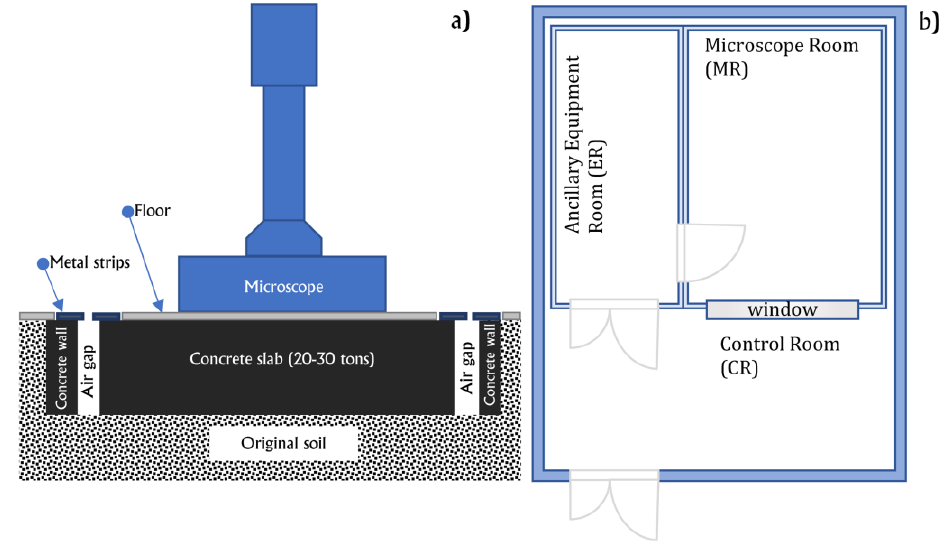
Figure 4. ( a ) Scheme of the anti-vibration block under the microscope in the Instrument Room (not in scale); ( b ) Scheme describing the room-in-room concept design.